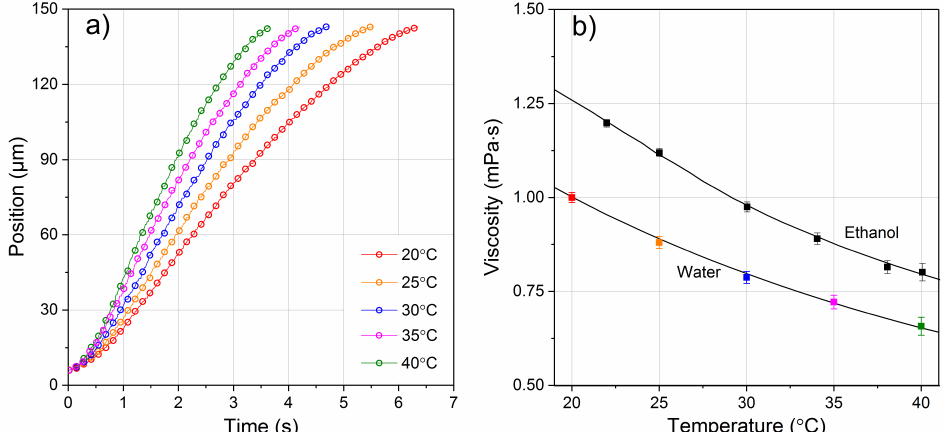
Figure 7. ( a ) Experimentally retrieved optical shooting trajectories of a PMMA bead in water at the same optical power but at different temperature values. The error bars of the position would be smaller than the circle size itself and are thus not shown. Note that all the trajectories have the same starting and finishing positions; ( b ) water and ethanol viscosity values at different temperatures are retrieved from the shooting trajectories. Viscosity for water corresponds to the trajectories in ( a ). Obtained results in dots are compared with curves reported in literature